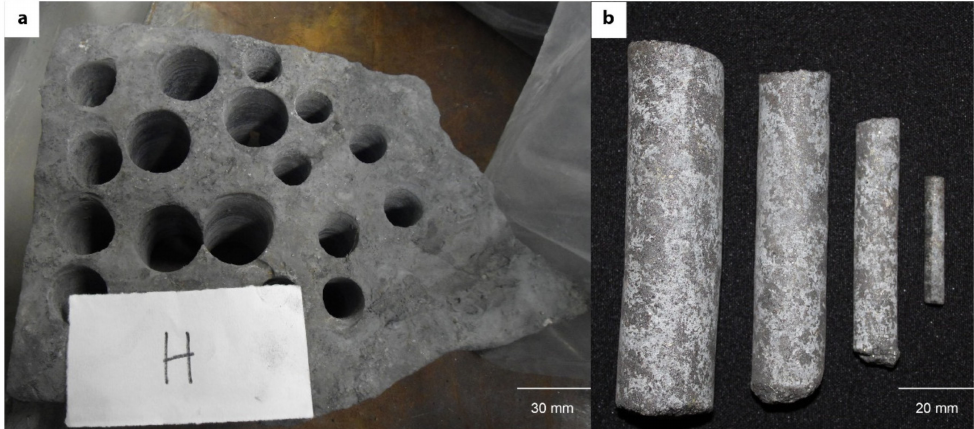
Figure 2. Coring of ( a ) grab samples to produce cores with diameters of ( b ) 26, 19, 14 and 6 mm per sample (example given for the magnetite-bearing